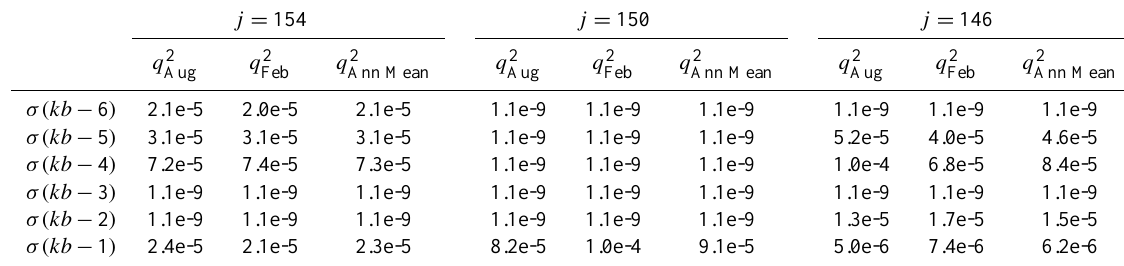
q 2 q 2 q 2 Aug Ann Mean Feb